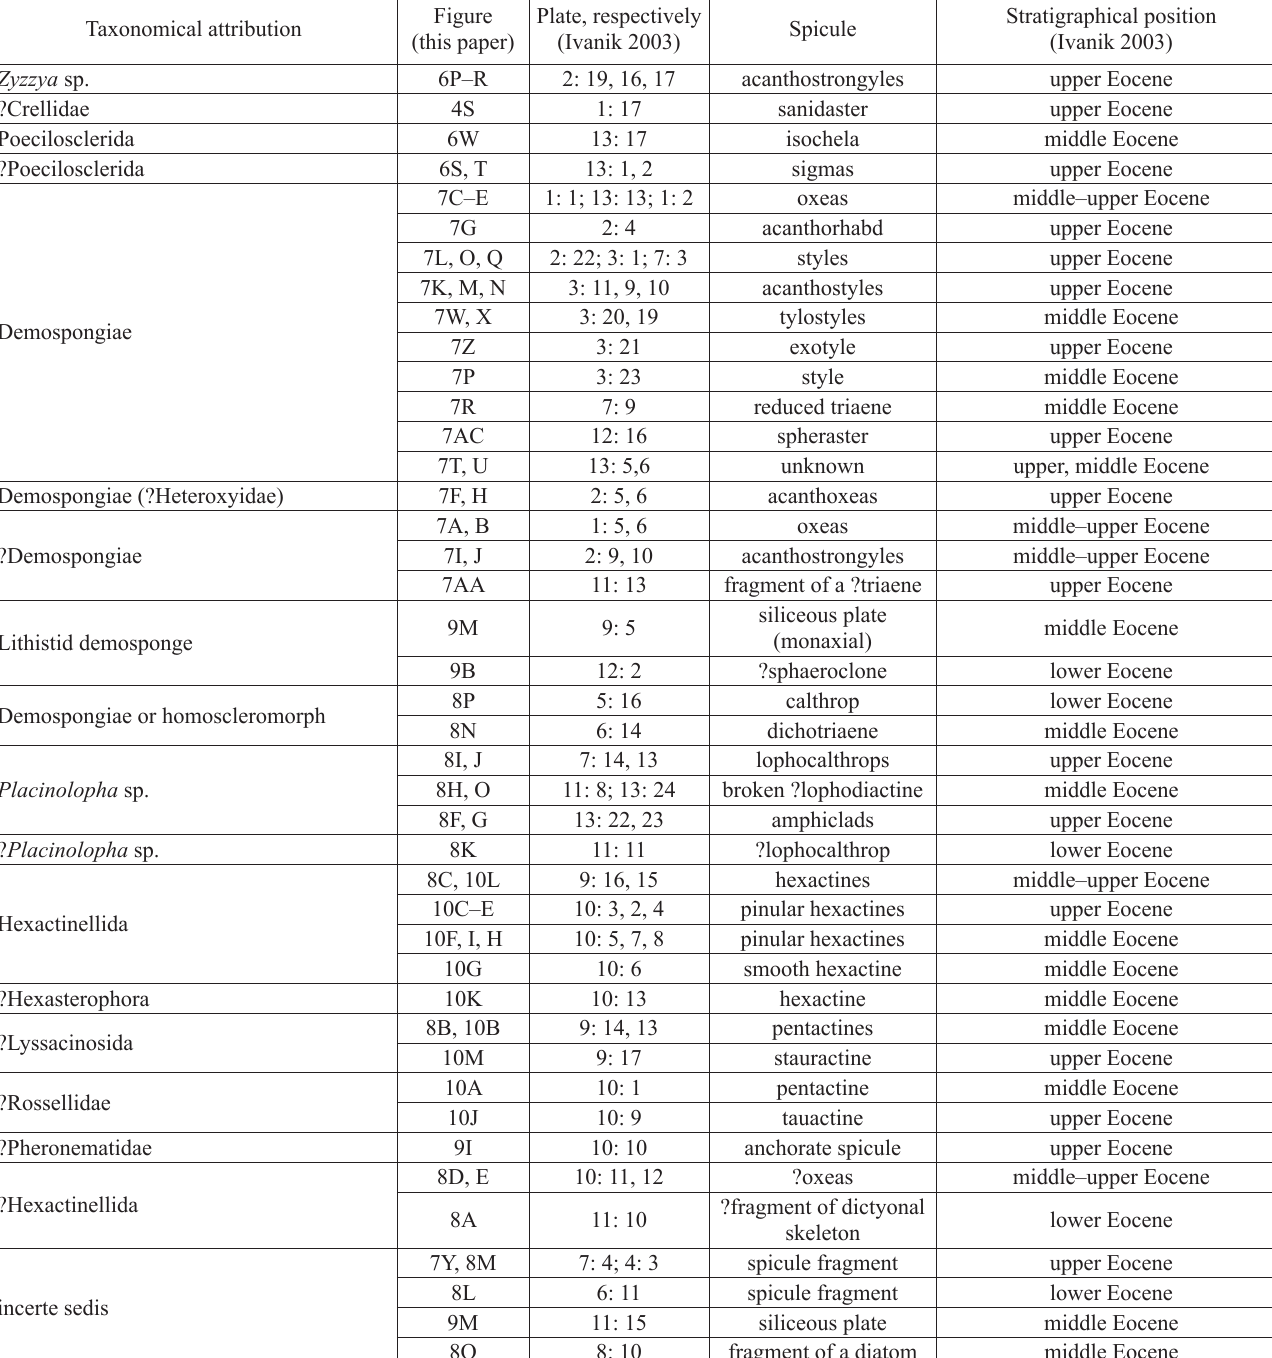
Figs. 1O, Z, 2E, H, K, R, U, V. Material .—Lower, middle–upper Eocene, south-central Ukra